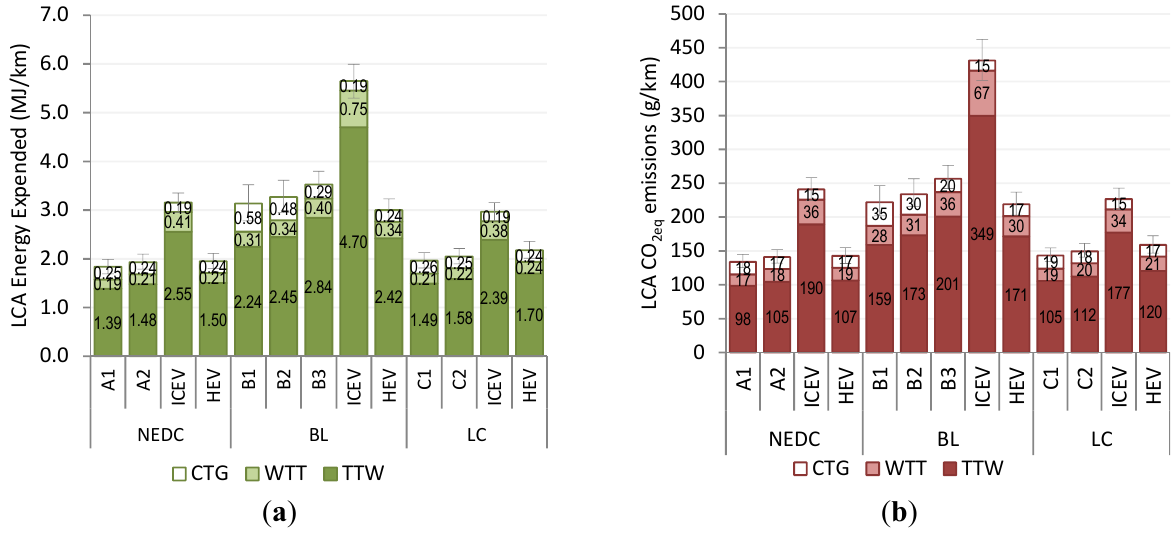
Figure 10. Life cycle energy use ( a ) and CO 2eq emissions ( b ), of the reference and optimal vehicles in NEDC, BL and LC driving cycles, for a lifetime distance of 650,000